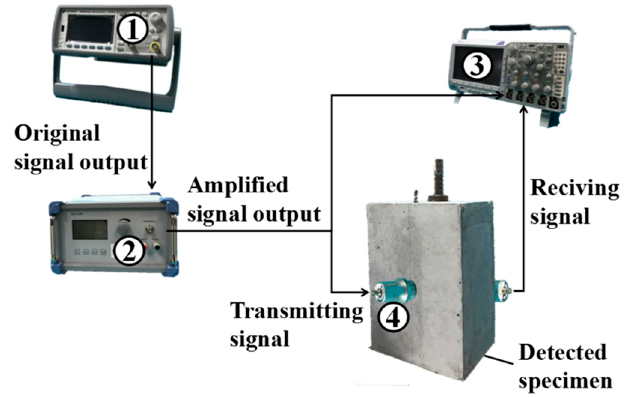
Figure 3. The schematic diagram of the detecting system.